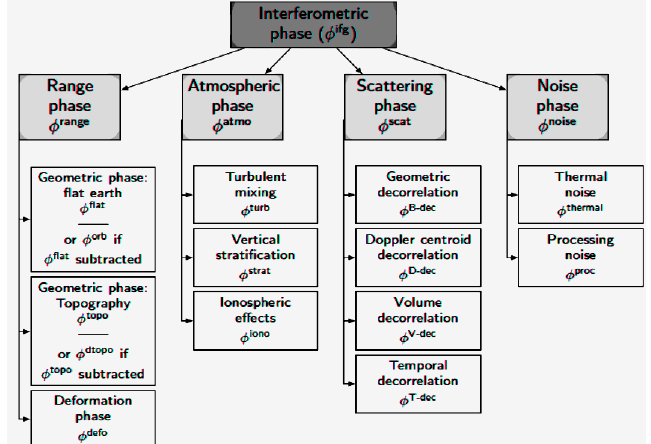
Figure 3. Decomposition of interferometric phase (Samiei Esfahany, 2017)